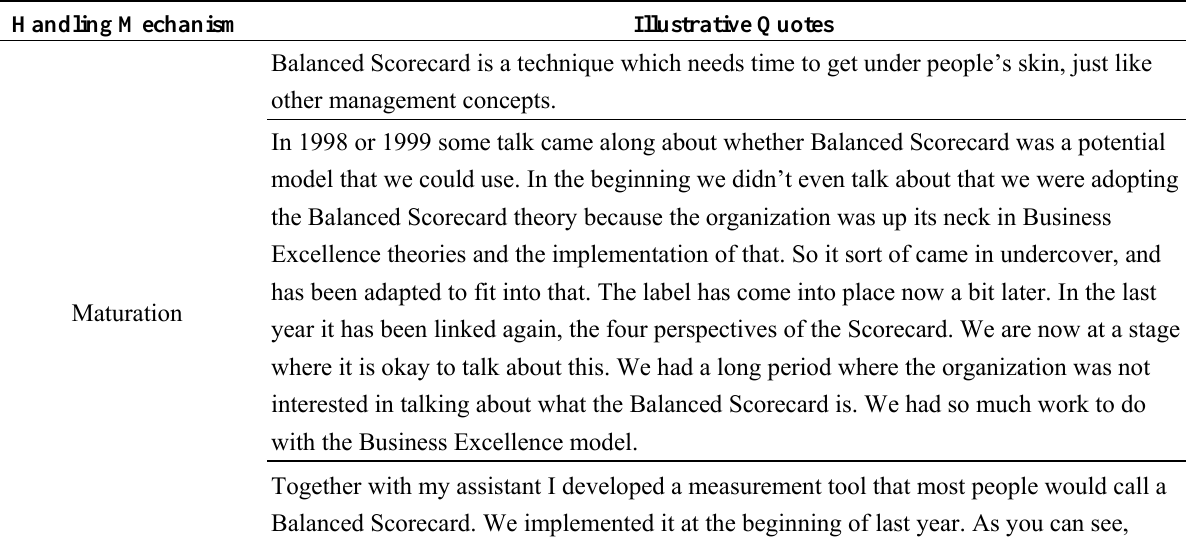
Table 10. Incubation of the